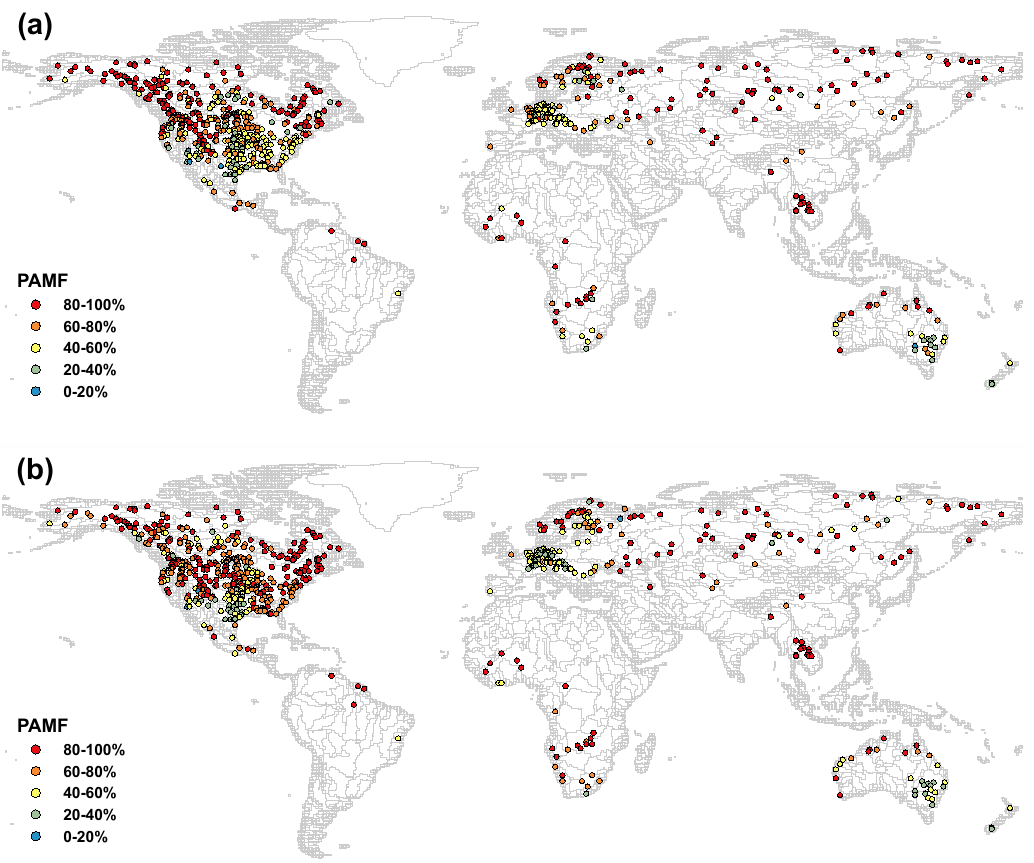
Figure 5. Calculated percentage of annual maximum flow (PAMF) values for (a) 691 GRDC observation stations and (b) simulated stream- flow at associated locations, subjectively classified as high (80–100%), moderate (60–80%), low (40–60%), and poor